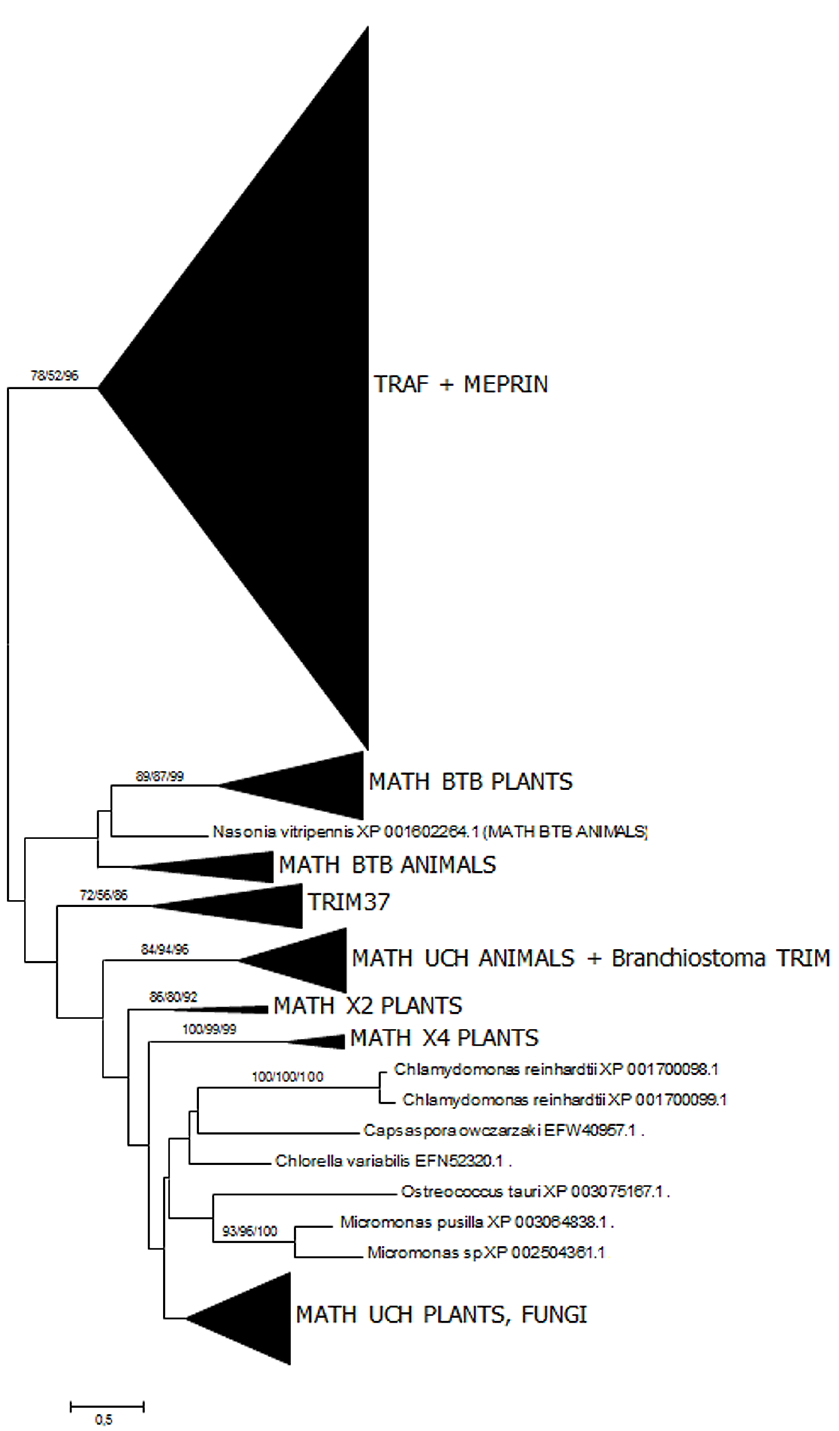
Fig 4. ML tree based on 822 MATH domain sequences. Numbers again refer to bootstrap support (NJ/MP/ ML; 1000 bootstrap replicates for NJ, 100 for MP and ML). Meprins and TRAFs appear together in a well- supported branch. The model used in the ML analysis was the Jones-Taylor-Thornton (JTT) model of amino acidic substitutions, with G distribution (JTT+G model). MP trees were explored using the SPR algorithm.